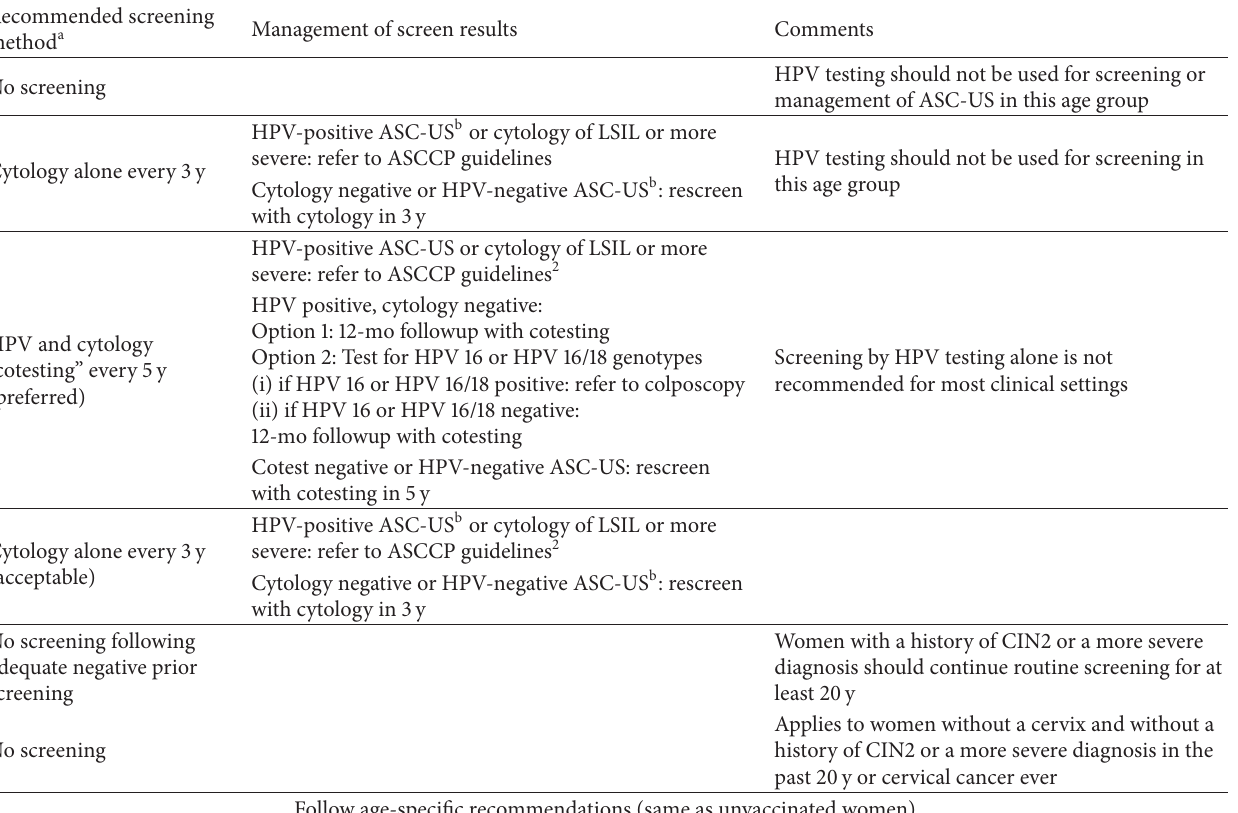
Table1:Summaryofrecommendationsthatreflectthebestevidence-basedpracticeforthepreventionofCCmorbidityandmortalitythrough currently available screening tests that maximize protection against CC while minimizing the potential harms associated with false-positive results and